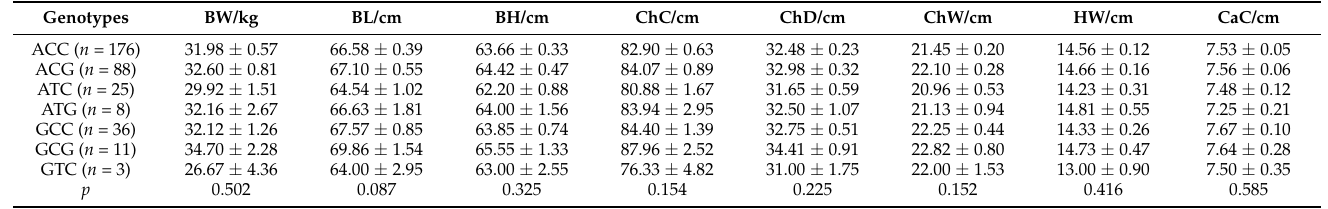
Table 7. Association analysis of haplotypes in SSTR1 with growth traits of Hulun Buir sheep at 9 months of age 1 .